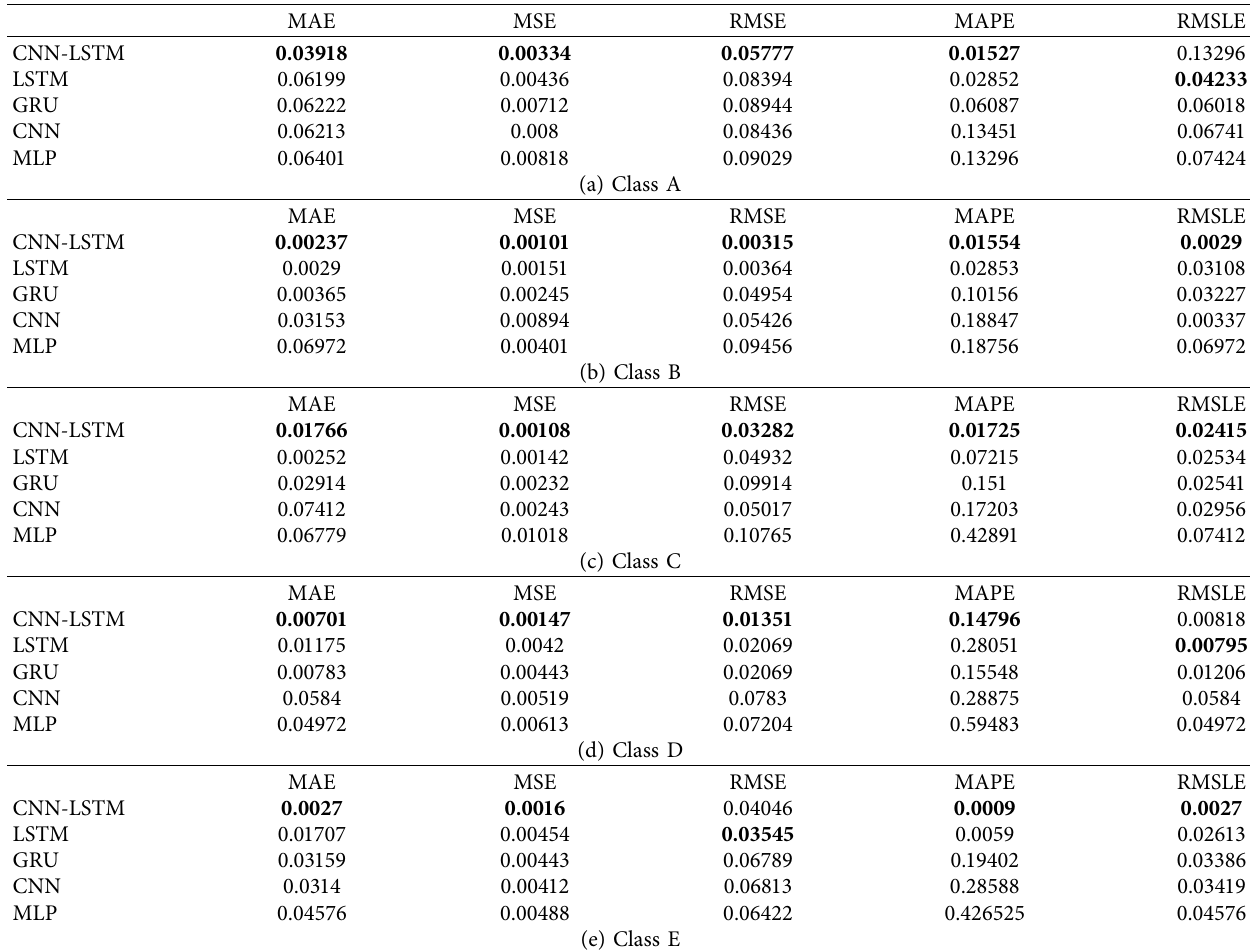
Table 13: Deep learning for combined features evaluation